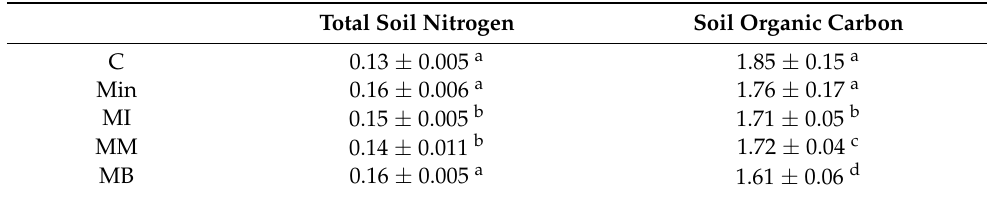
Table 2. Soil organic carbon (%) and soil nitrogen (TN) measured using samples collected from maize plots with different fertilizer treatments at the research farm at Jomo Kenyatta University Kenya during growing season